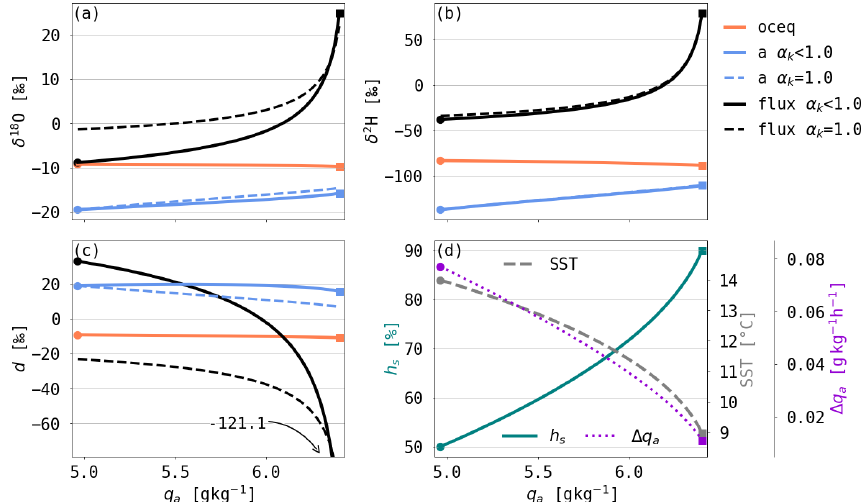
Figure 3. Evolution of (a) δ 18 O, (b) δ 2 H and (c) d as a function of the air parcel’s specific humidity q a in an example simulation with APM evap (see text for details). The blue line shows the isotopic composition of the water vapour in the air parcel (a), the orange line shows that of the equilibrium vapour with the ocean surface (oceq) and the black line shows that of the evaporation flux (flux). For d flux , the end composition is not shown but indicated by − 121 . 1‰ in panel (c) . Panel (d) shows the SST (grey dashed line), h s (green solid line) and (cid:49)q a (violet dotted line) during the simulation. The values of (cid:49)q a are calculated assuming that the SST decrease occurred over 36h. The simulation is shown with non-equilibrium fractionation ( α k < 1 . 0, solid lines in panels a – c ) and without ( α k = 1 . 0, dashed lines in panels a – c ). The dots denote the start and the squares the end of the